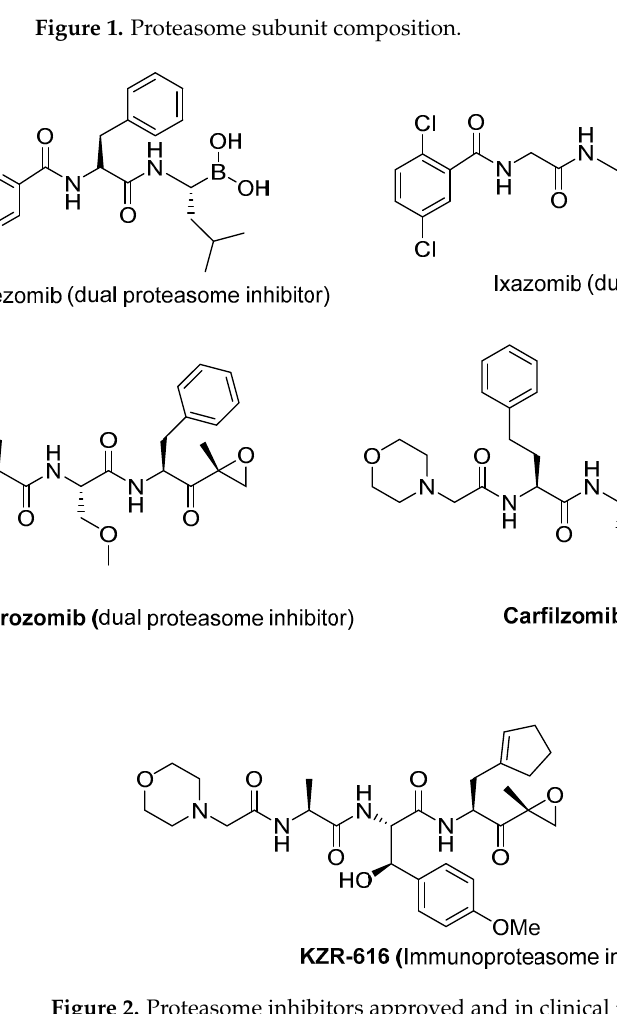
Figure 2. Proteasome inhibitors approved and in clinical trials. Table 1. Properties of proteasome inhibitors and their clinical use.